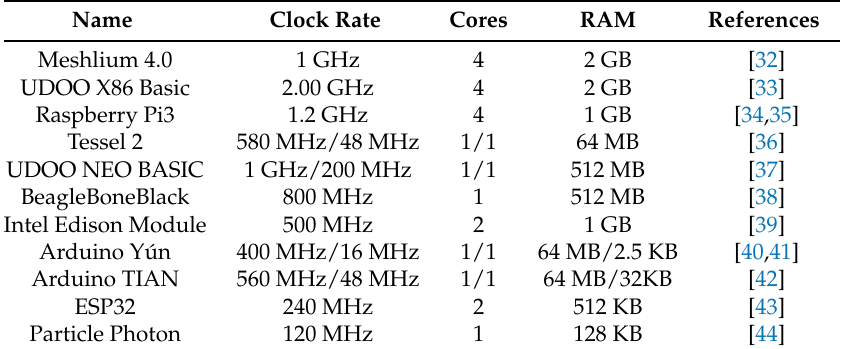
Table 1. Characteristics of some of the latest Internet of Things (IoT) development